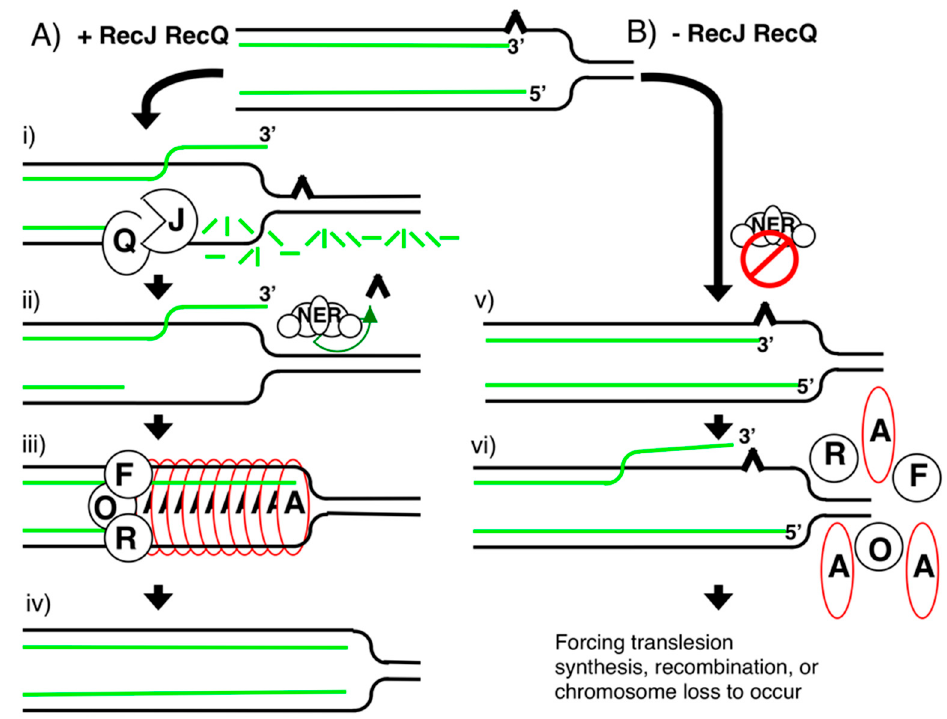
Figure 6. Model for how RecQ and RecJ suppress rearrangements and mutations. ( A ) RecJ-RecQ- mediated degradation of the nascent lagging strand at arrested replication forks (i) restores the lesion-containing region to a double-stranded form that can be repaired (ii) and creates a large substrate (region of single-stranded DNA with homologous duplex DNA) at the fork that RecF-O-R and RecA can bind and stabilize (iii) so that replication can resume (iv). ( B ) In the absence of RecJ- RecQ degradation, the region containing the lesion remains in single-stranded form, preventing its repair, and delaying the recovery until translesion synthesis can occur (v). Additionally, in the absence of RecJ-RecQ processing, RecF-O-R and RecA are unable to bind, leading to recombination at the disrupted site and compromising viability if translesion synthesis cannot occur (vi).